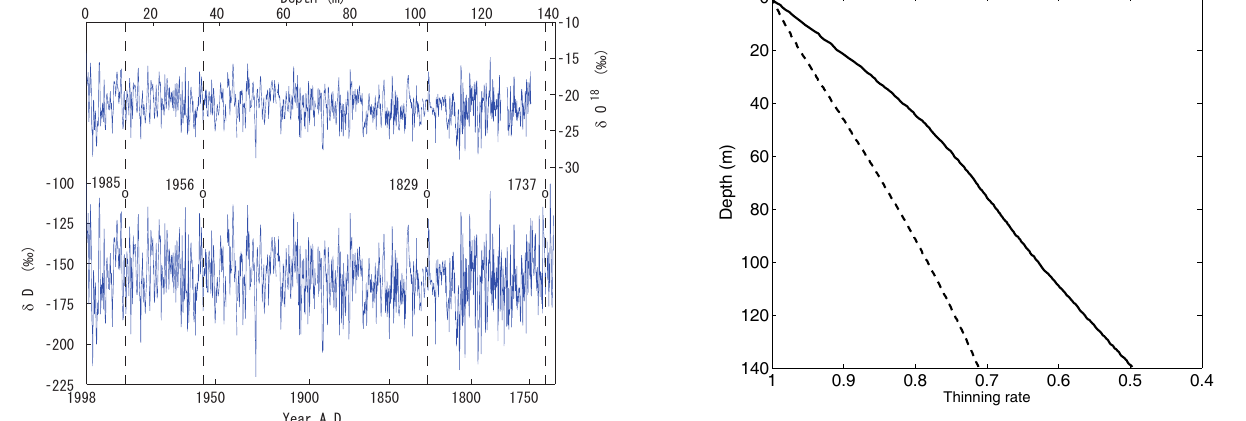
Fig. 3. Measured water isotope profiles with dating results. Upper line: δ 18 O, lower line: δ D. Dotted lines with year number indicate dated volcanic ash layers ( Murav’yev et al., 2007).